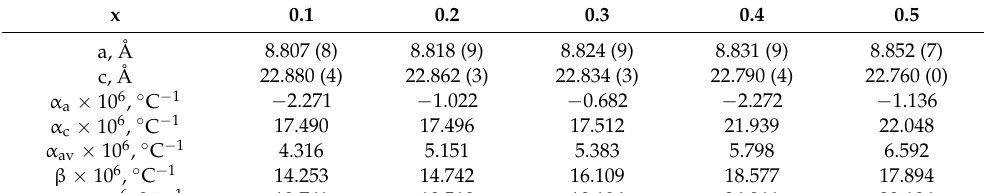
Figure 4. Dependences of crystal lattice parameters a and c on the composition of compounds